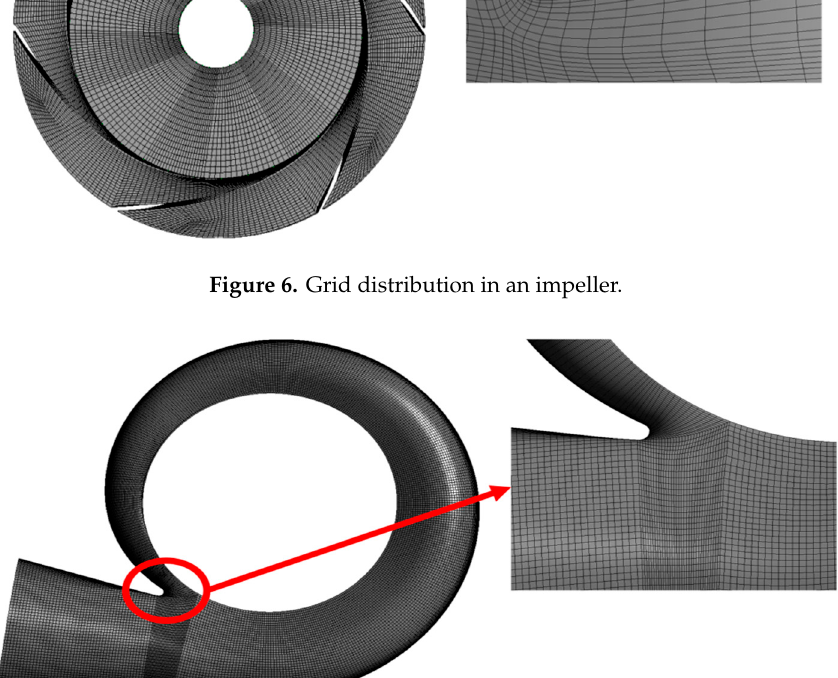
Figure 6. Grid distribution in an impeller.